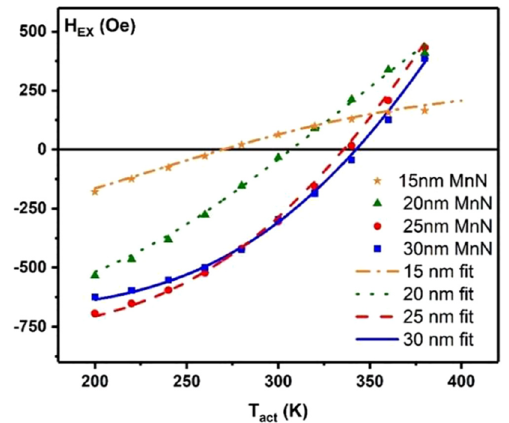
Figure 7. Reverse field cooling experiment as a function of the MnN thickness. (Reproduced with permission from G. Vallejo-Fernandez, Journal of Magnetism and Magnetic Materials; published by Elsevier, 2019) [24.